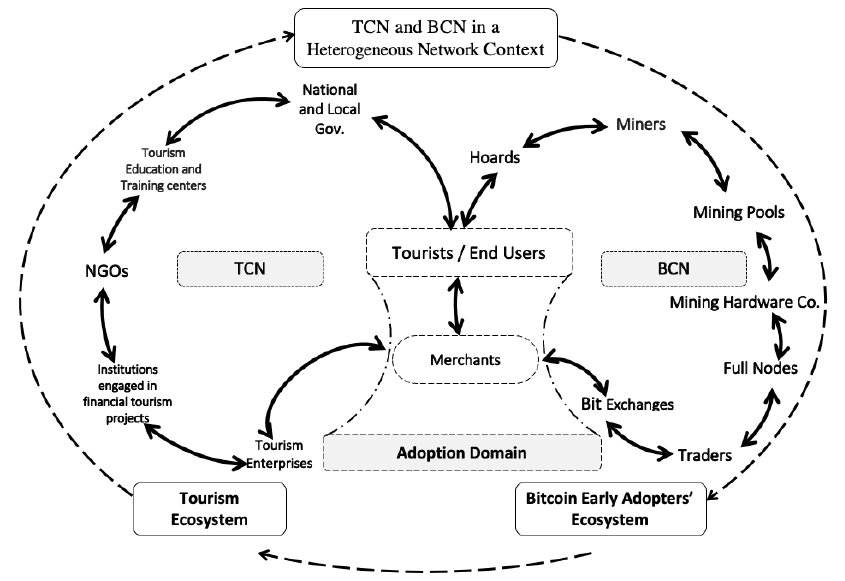
Fig. 1 Bitcoin Collaborative Network and Tourism Collaborative Network adopted from Daryaei et al.,